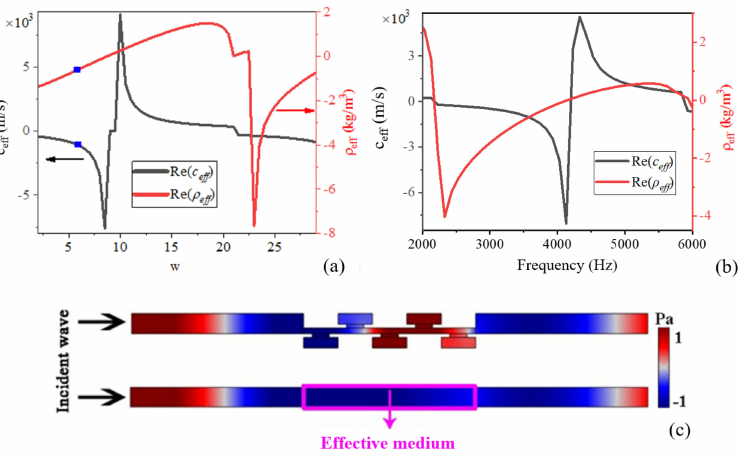
Figure 2. The relationship between equivalent density and velocity with ( a ) scale factor ‘ w ’ and ( b ) frequency. Here, c = 1.0, and c eff is equivalent velocity. ( c ) Acoustic field distribution in waveguide unit with w = 6 and its effective medium. The working frequency is 3430